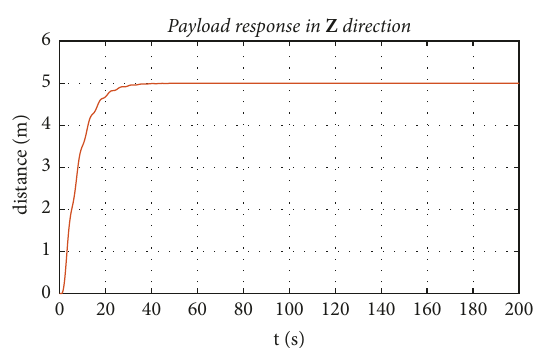
Figure 6: Payload responsein Zdirection without vibration control.